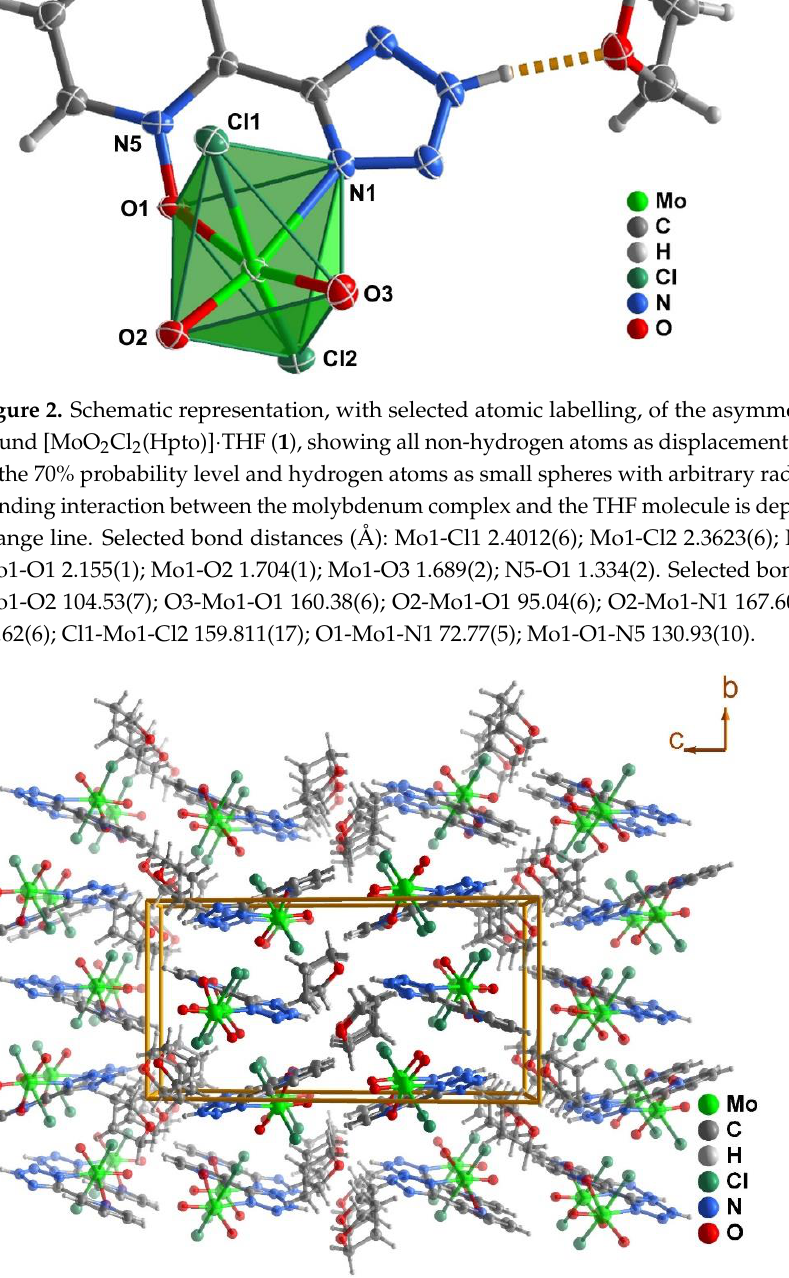
Figure 3. Schematic representation of the crystal packing of compound [MoO 2 Cl 2 (Hpto)]·THF ( 1 ) viewed in perspective along the [100] direction of the unit cell. The FT-IR spectrum of 1 displays a strong band at 909 cm − 1 , assigned to ν asym (Mo=O), and a weaker one at 944 cm − 1 , assigned to ν sym (Mo=O), confirming the presence of a cis -[MoO 2 ] 2+ unit (Figure 4A). The corresponding bands appear in the Raman spectrum at 913 and 946 cm − 1 with weak and strong intensity, respectively (Figure 4B). For comparison, the complex (H 2 ptz)[MoO 2 Cl 2 (ptz)] displayed a similar pair of bands at 914–915 cm − 1